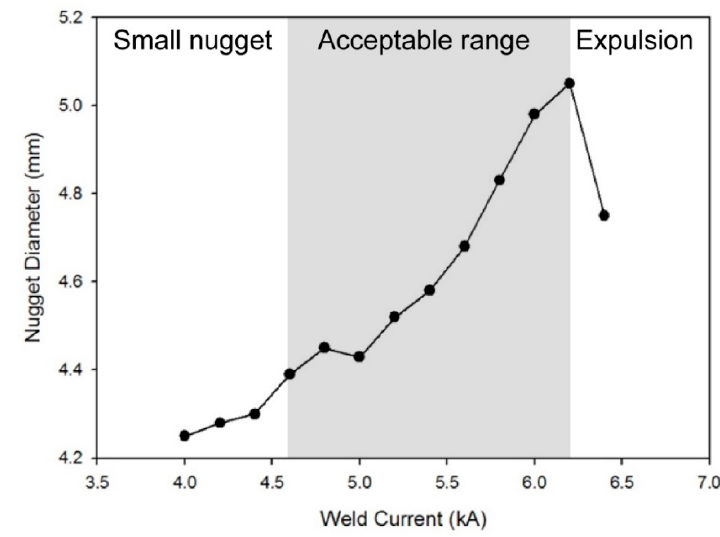
Figure 1. Welding current range of 15B22.